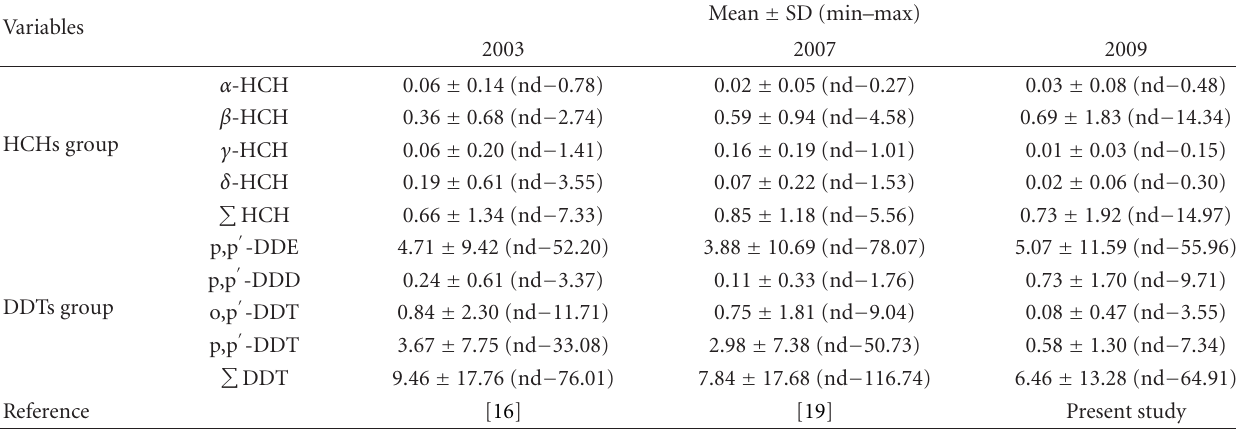
Table 1: Concentrations (ng/g dw) of OCPs in soil samples in 2003, 2007, and 2009. Variables